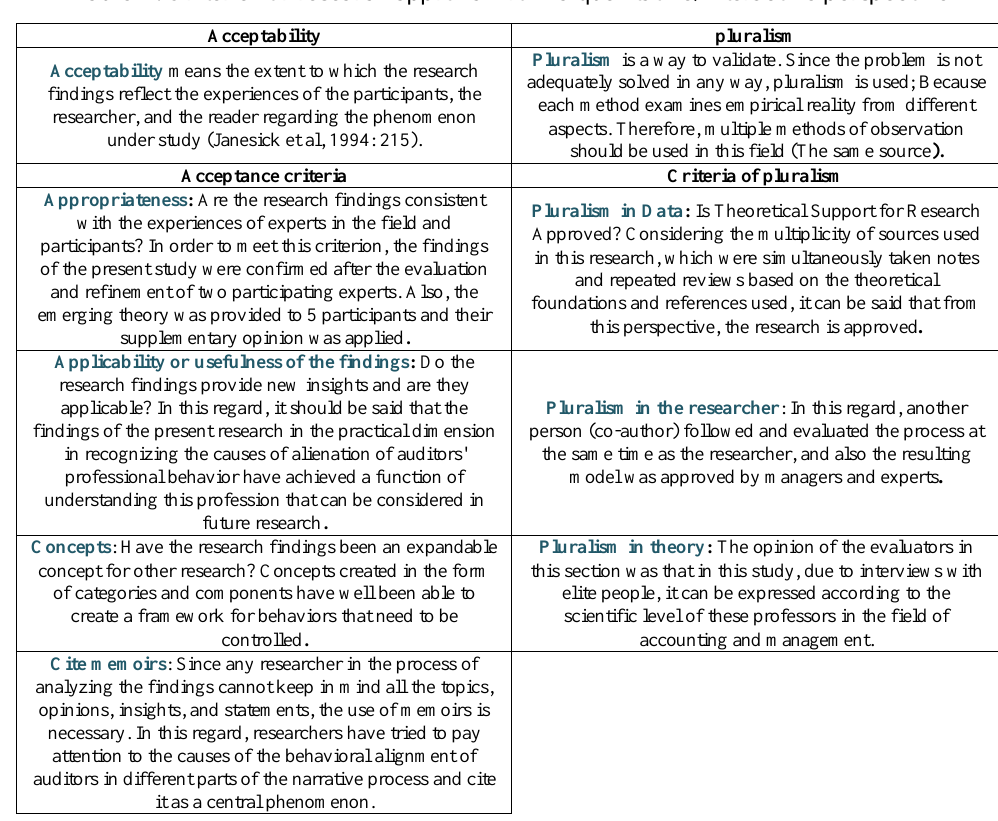
Table 2. Criteria for research approval from a qualitative/interactive